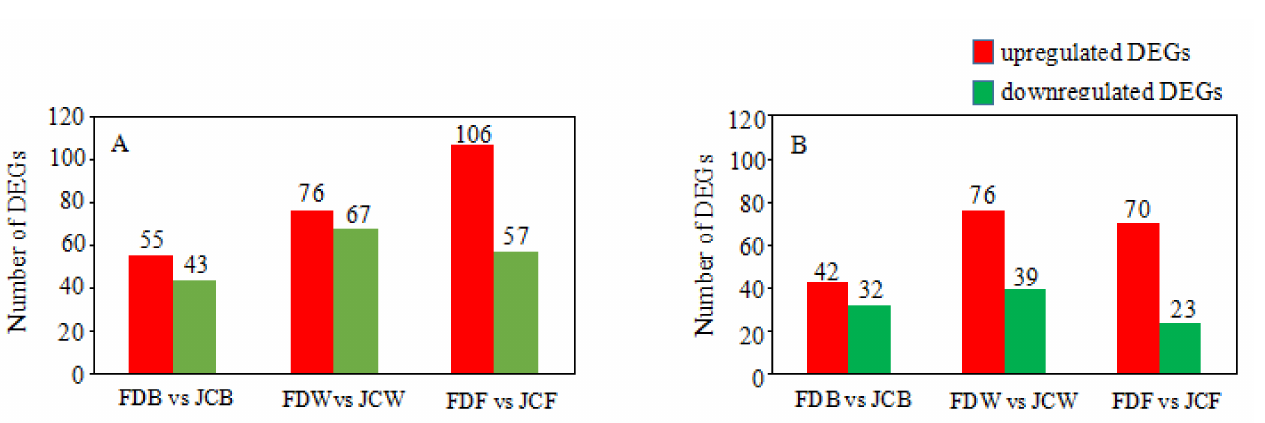
Figure 5. The number of DEGs in plant–pathogen interaction ( A ) and phenylpropanoid biosynthesis ( B